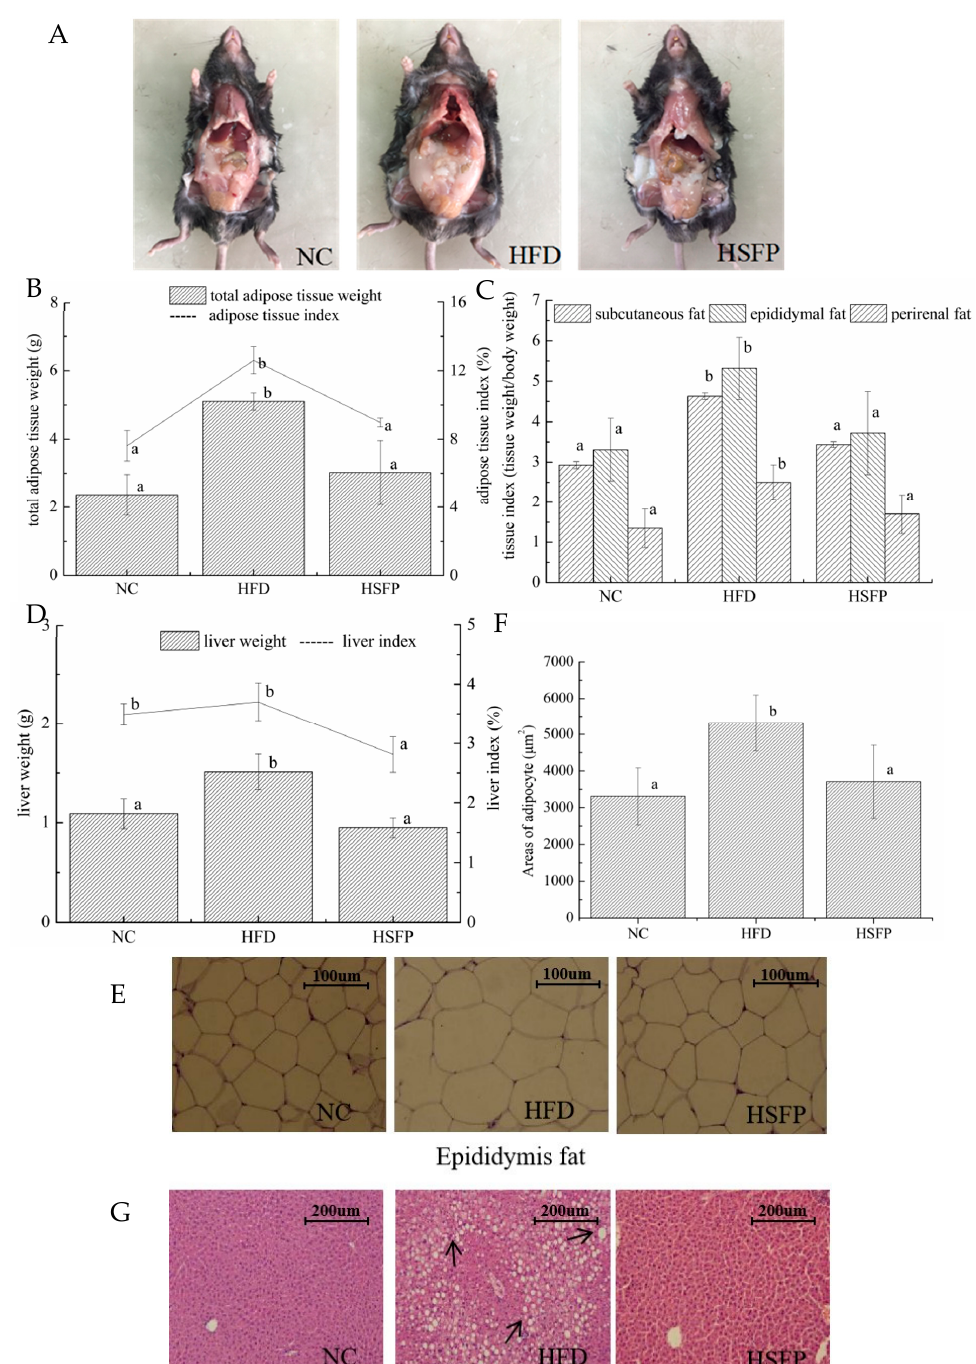
Figure 2. Seabuckthorn freeze-dried powder supplementation attenuates high-fat diet-induced fat accumulation, adipocyte hypertrophy, and hepatic steatosis. ( A ) Anatomy, ( B , C ) total adipose tissue weight, and three parts adipose tissue weight. ( D ) Liver weight. ( E ) H&E staining of epididymal white adipose tissue sections (scale: 100 µm, photographed at 400× magnification) and ( F ) average area of adipocyte. ( G ) H&E staining of liver sections (scale: 200 µm, photographed at 200× magnification). In our study, all data are expressed as means ± SD. Graph bars with different letters on the top correspond to statistically significant results ( p < 0.05) based on one-way ANOVA analysis followed by Duncan’s multiple range